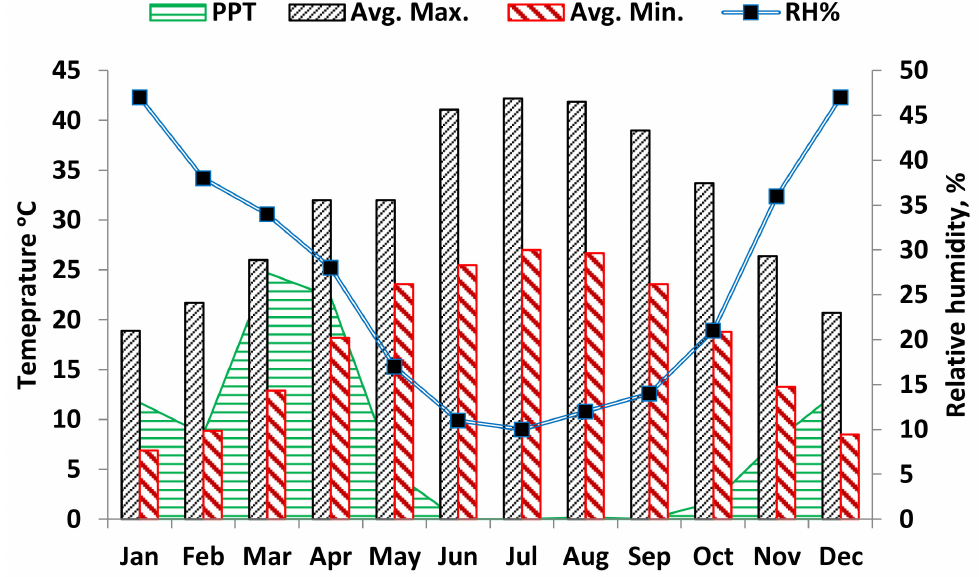
Figure 2. Weather data of Al-Dwadimi town Reprinted from Ref. [54]. PPT denotes